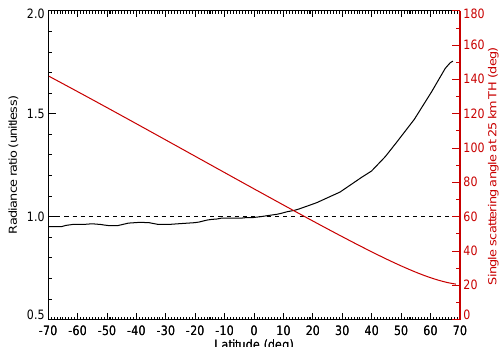
Figure 3. The GSLS-modeled ratio of 350nm limb-scattered radi- ances at 20.5km with and without aerosols (left axis) and single- scattering angle (right axis) as a function of latitude. A nominal latitude-independent aerosol extinction profile was used in the cal- culation for the OMPS LP viewing geometry on 2 February 2012. The strong latitude dependence is caused by an order of magnitude change in aerosol scattering phase function with latitude combined with the attenuation of Rayleigh-scattered radiation by aerosols along the line of sight (LOS). In the Southern Hemisphere, where LP measures aerosols in the backscatter direction, the latter effect dominates and the radiation decreases. The net effect is very sensi- tive to altitude, variation of aerosol extinction profile along the LOS, and aerosol particle size distribution, and it is therefore difficult to calculate